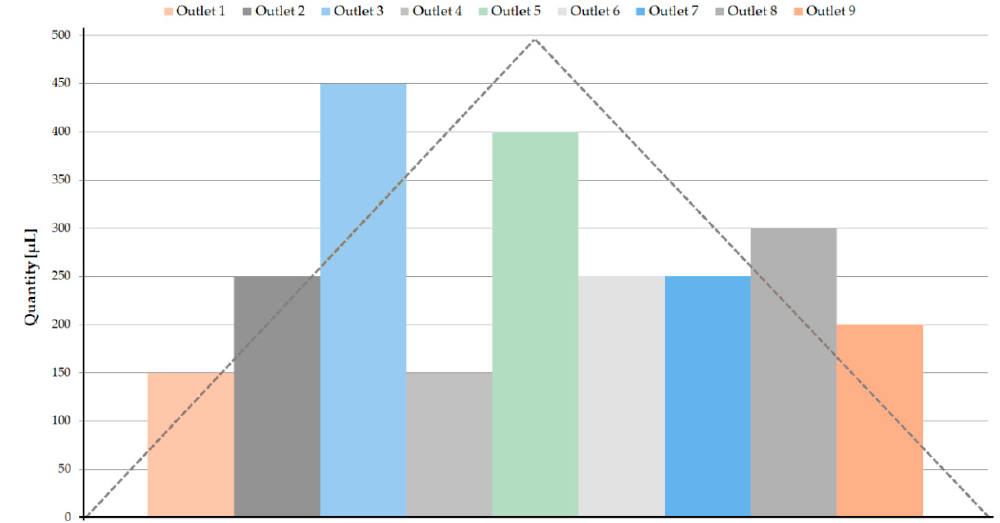
Figure 3. Volumes of the samples collected in the Eppendorf tubes. The dashed line represents an approximation of the expected behavior of the collected sample volumes in each outlet.